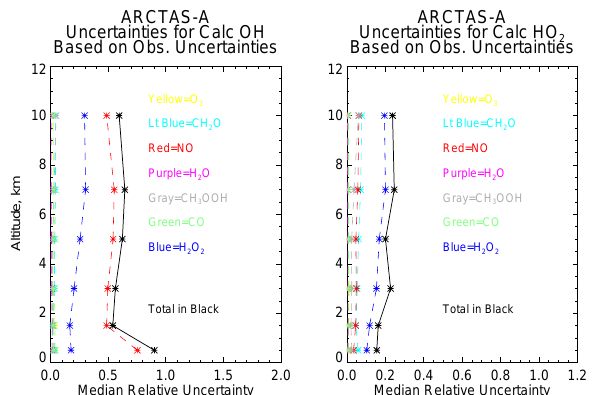
Fig. A1. Altitude profiles of the median relative uncertainty in pre- diction of (a) OH and of (b) HO 2 during ARCTAS-A that is due to the uncertainty in observations of constraining species.